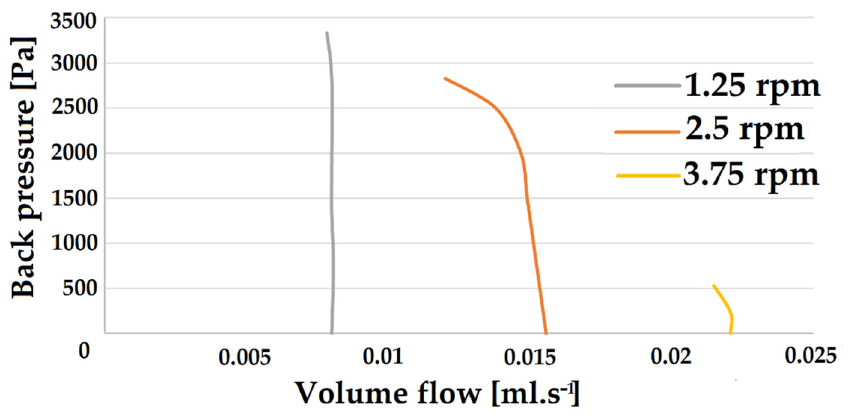
Figure 6. Pump curves for three different operating conditions.